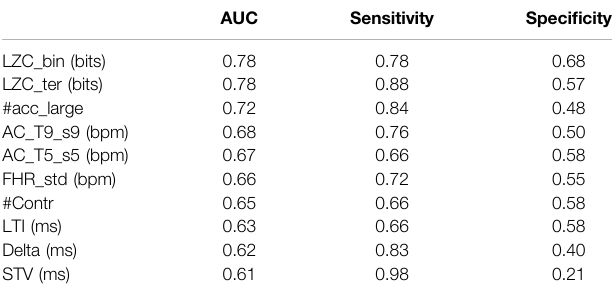
TABLE 2 | Univariate performance.